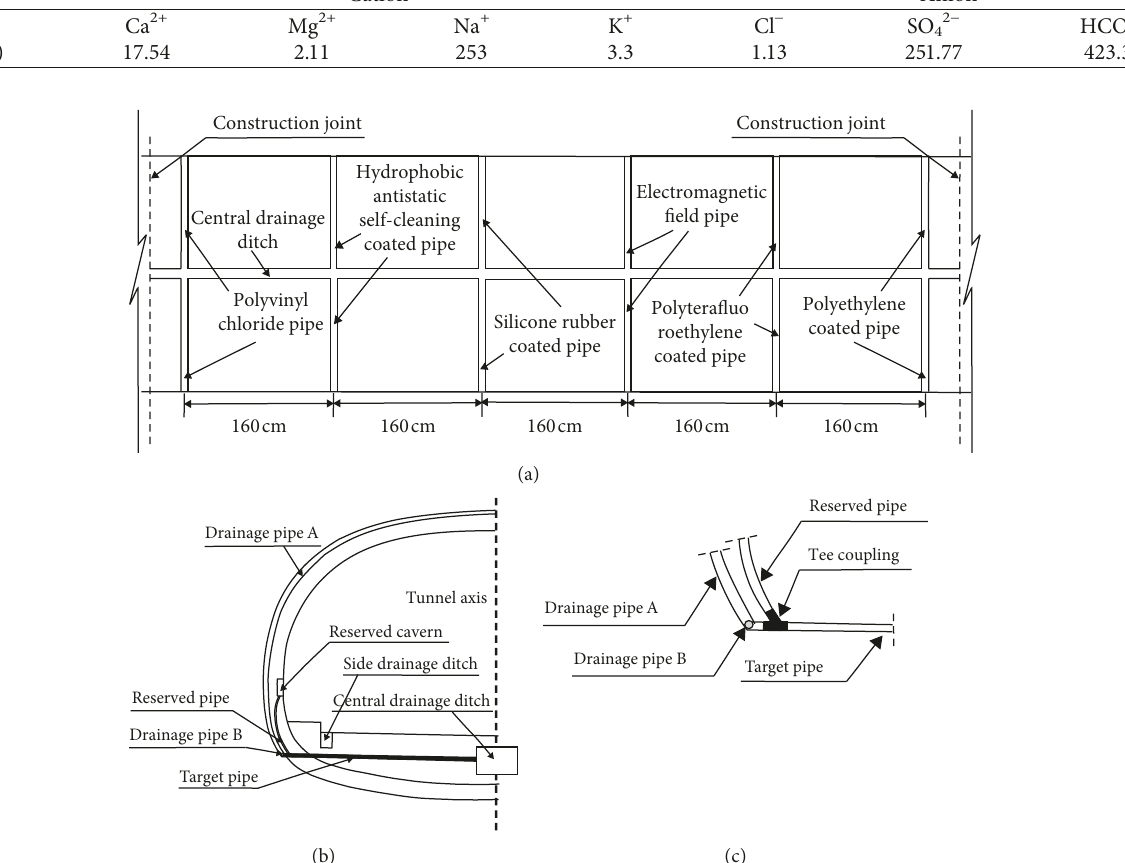
Figure 6: Layout of the field test pipes. (a) Plane layout. (b) Layout of half cross section. (c) Details between reserved pipe and target